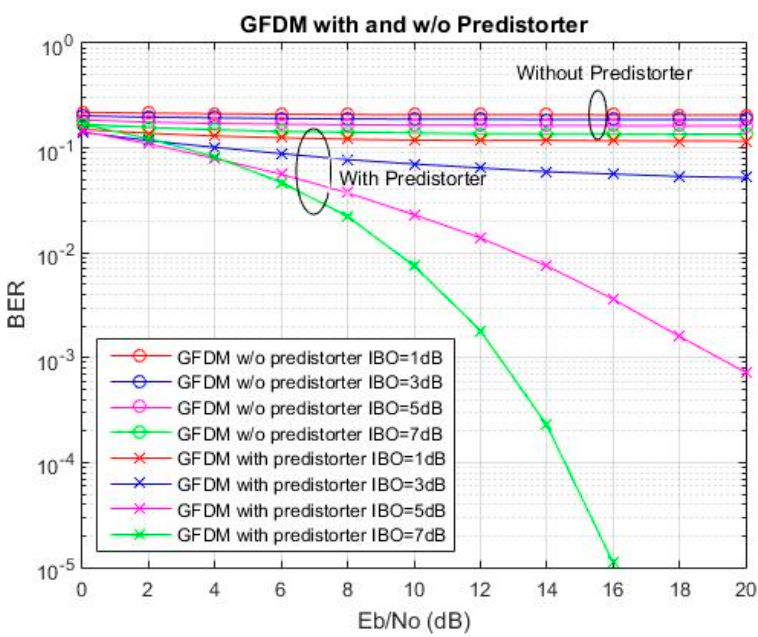
Figure 15. Bit error rate (BER) of GFDM + predistorter with IBO variations.